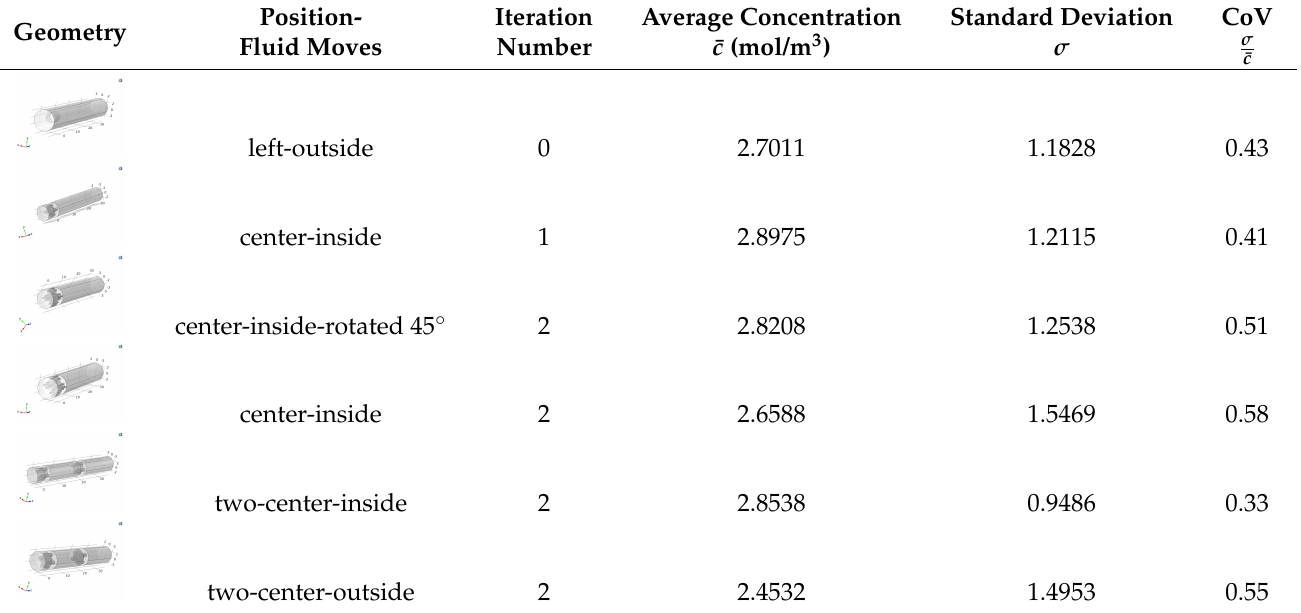
Table 3. Values of CoV, which indicates the quality of mixing the two fluids using the circular fractal patterns and obstacles with triangle